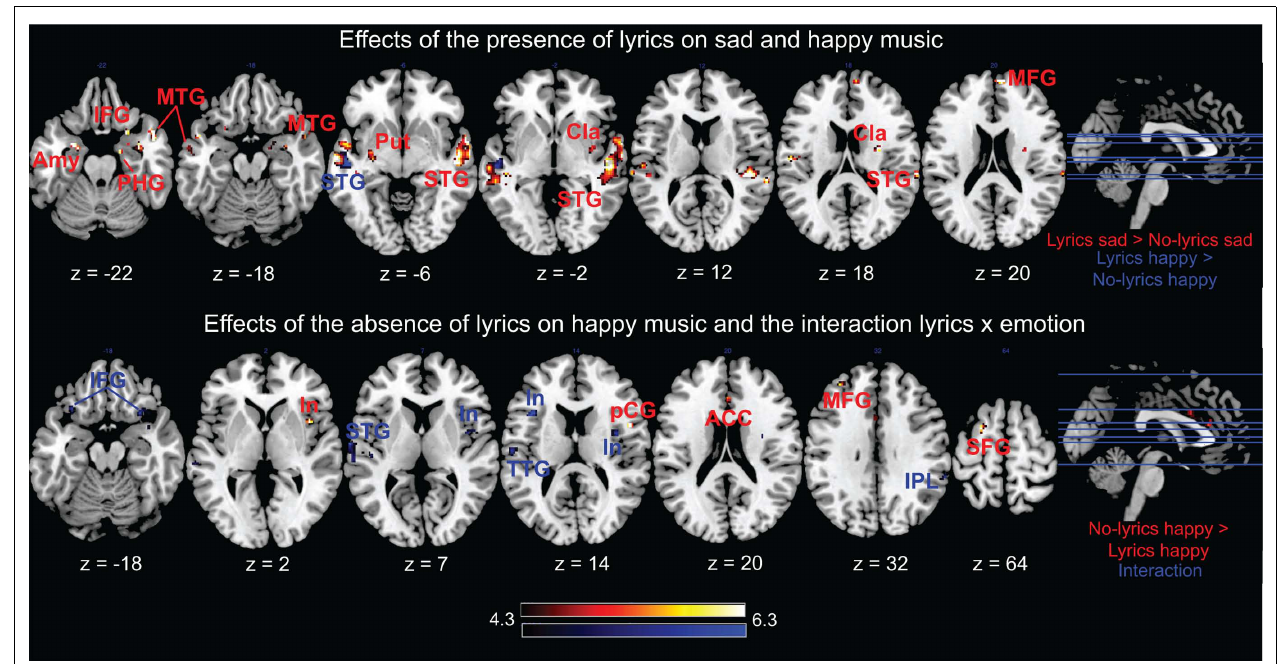
gyrus; PHG, parahippocampal gyrus; pCG, precentral gyrus; Put, putamen; SFG, superior frontal gyrus; STG, superior temporal gyrus; andTTG, transverse temporal gyrus. Activations were considered significant at p < 0.001, Z > 3.5, and k >